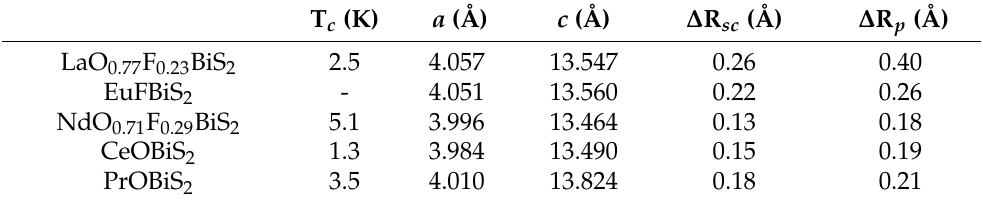
Table 1. Lattice parameters of the tetragonal unit cell (Space group P4/nmm) of different compounds. The transition temperatures (T c ) and in-plane distortion amplitudes ( ∆ R) are also included. ∆ R sc rep- resents the separation between the two peaks in the pair distribution function derived in the present work while ∆ R p corresponds to the distortion amplitudes reported on polycrystalline